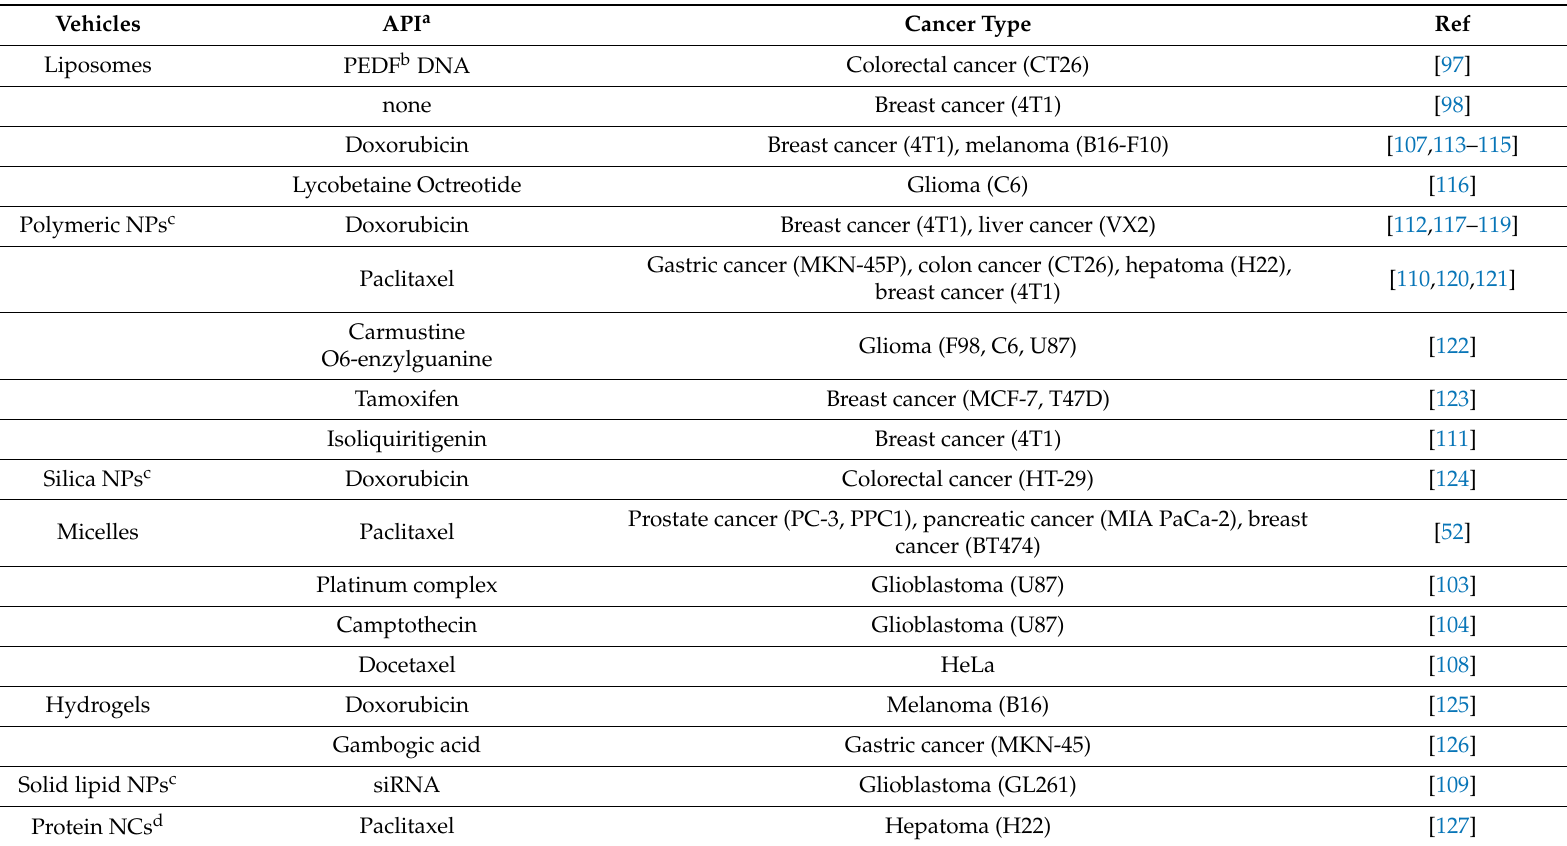
Table 1. Application of iRGD conjugation with therapeutic agents to improve the drug e ffi